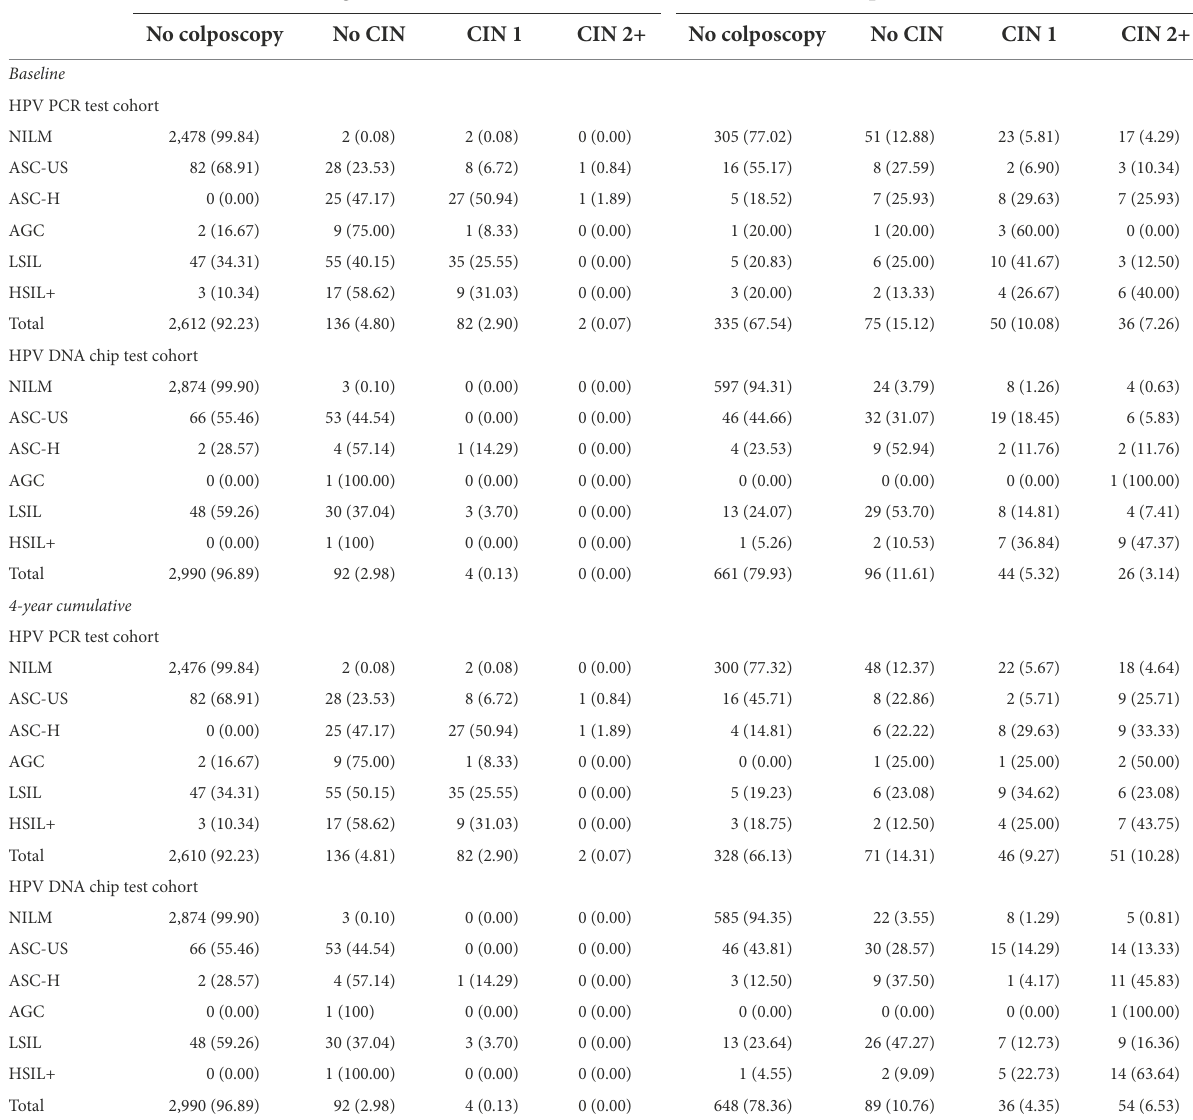
TABLE 2 Histopathological distribution in different cytological diagnoses regarding HPV